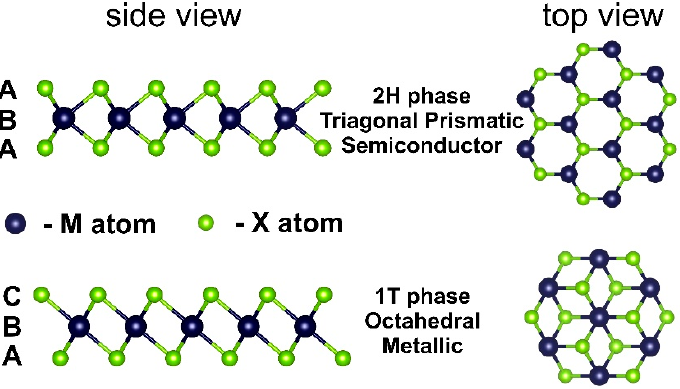
Figure 1. Different structural models of the 2H and 1T polymorphs in a MX 2 monolayer.